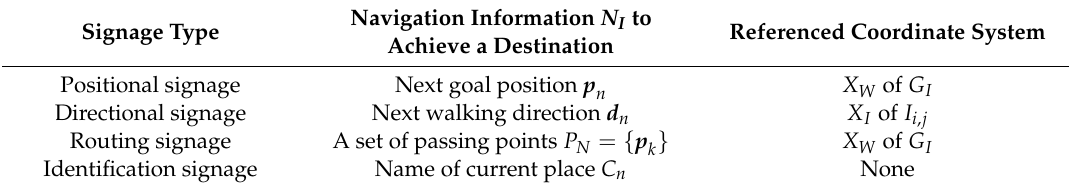
Table 3. Assignment of navigation information depending on signage